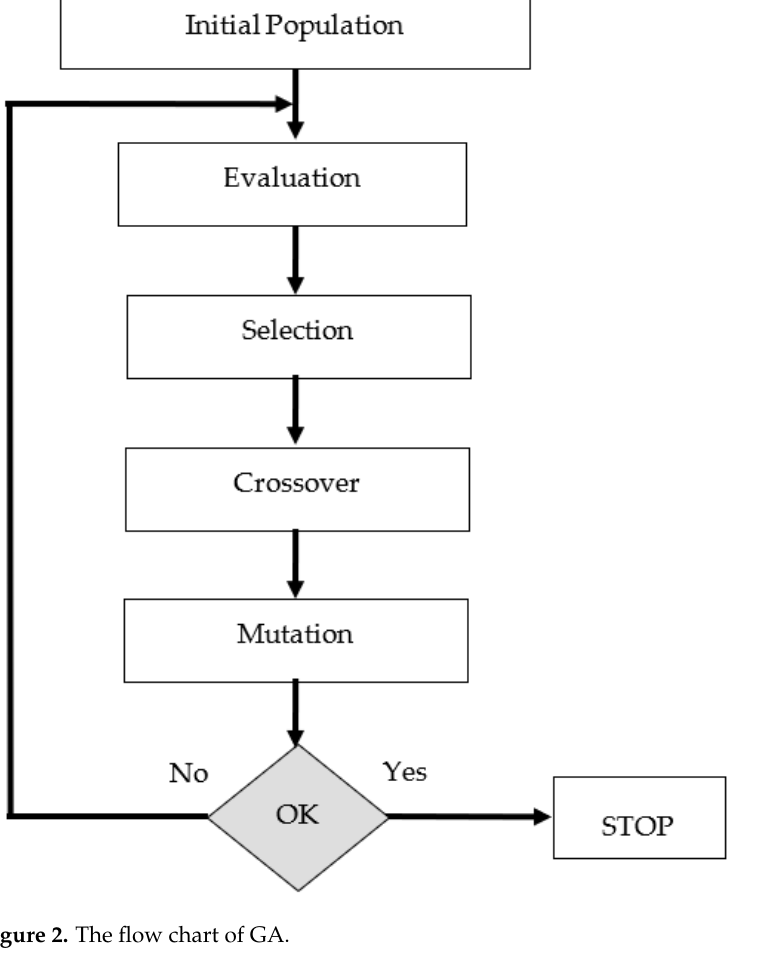
Figure 2. The flow chart of GA.